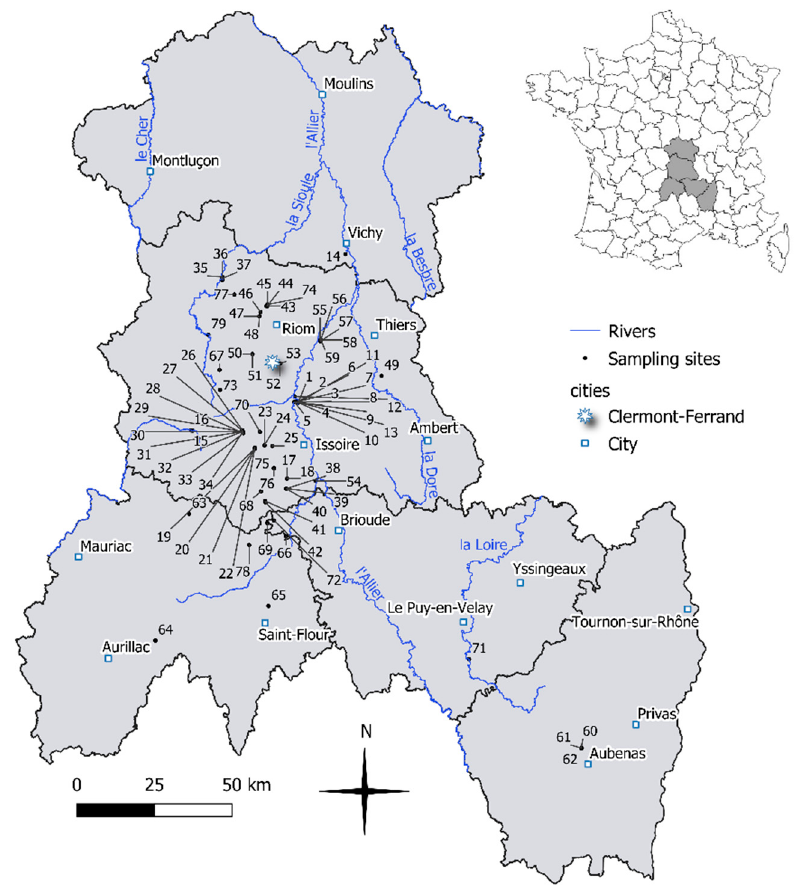
Figure 1. Map of the sampling sites (mineral springs). The correspondence between the spring number and its name is presented in Table S1.